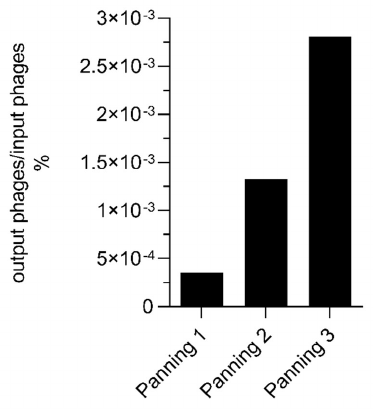
Figure 3. Percentage enrichment of polyclonal phage particles displaying different VHH fragments on their surfaces. The percentage enrichment was calculated by the division of the titer of output phages and titer of input phages multiplied by 100% for each panning round.